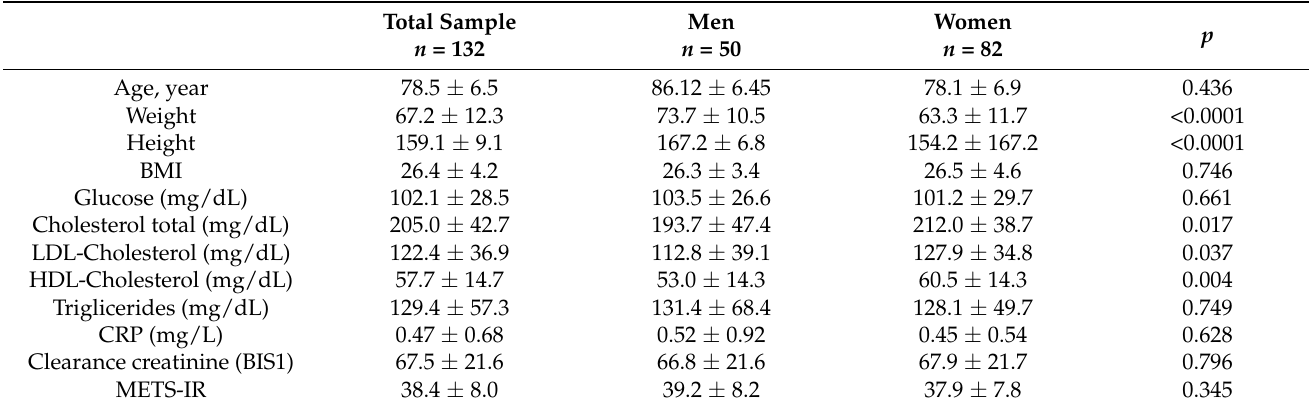
Table 1. Demographic and clinical characteristics of the total population sample ( n = 132), stratified by